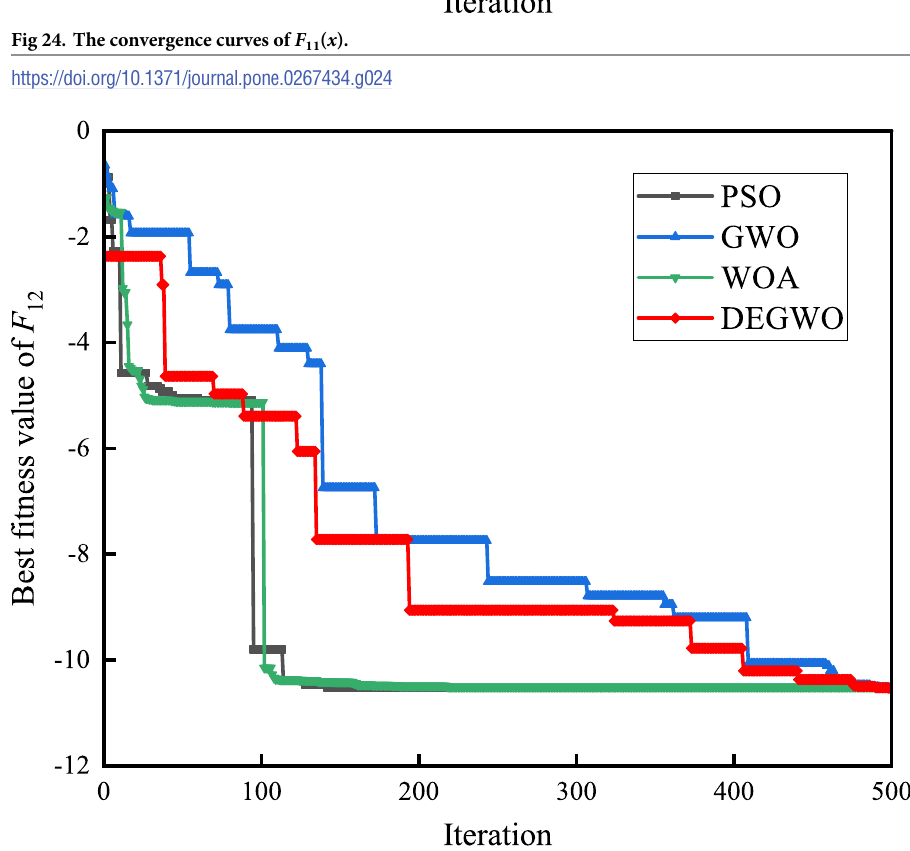
Fig 25. The convergence curves of F 12 ( x ).